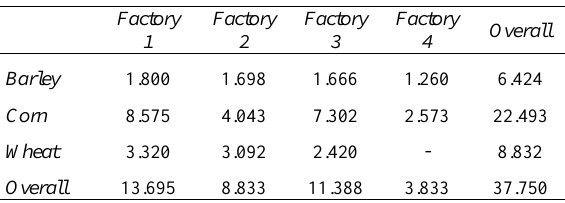
Table 9. Maximum in-house capacity requirement